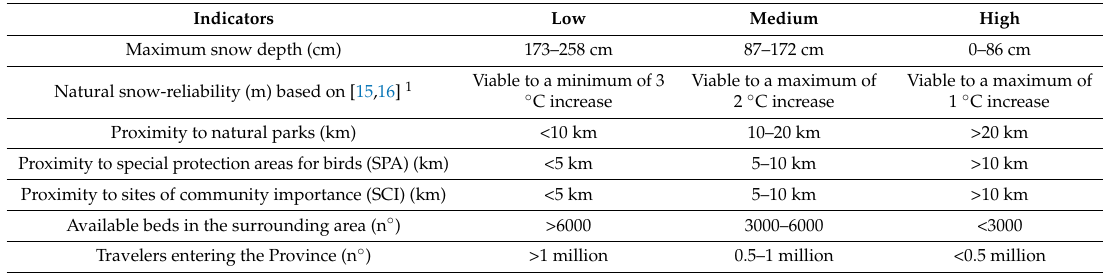
Table 3. Criteria for the definition of the vulnerability